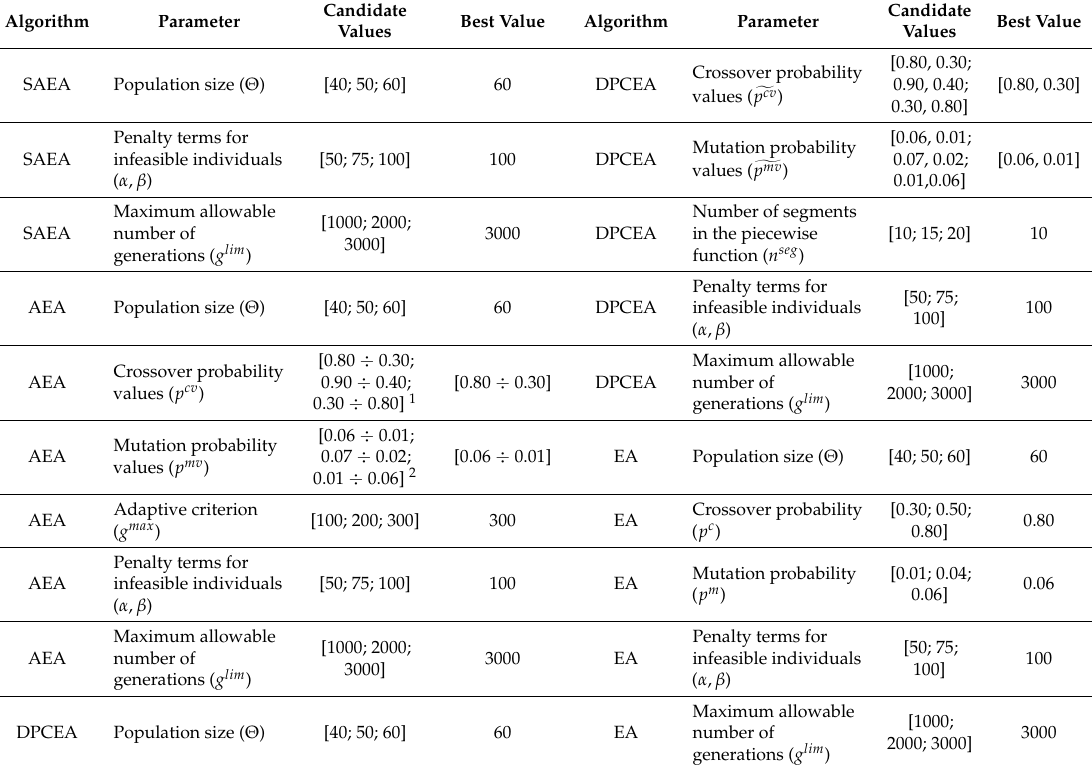
Table 3. The parameter tuning analysis results for the developed solution algorithms.